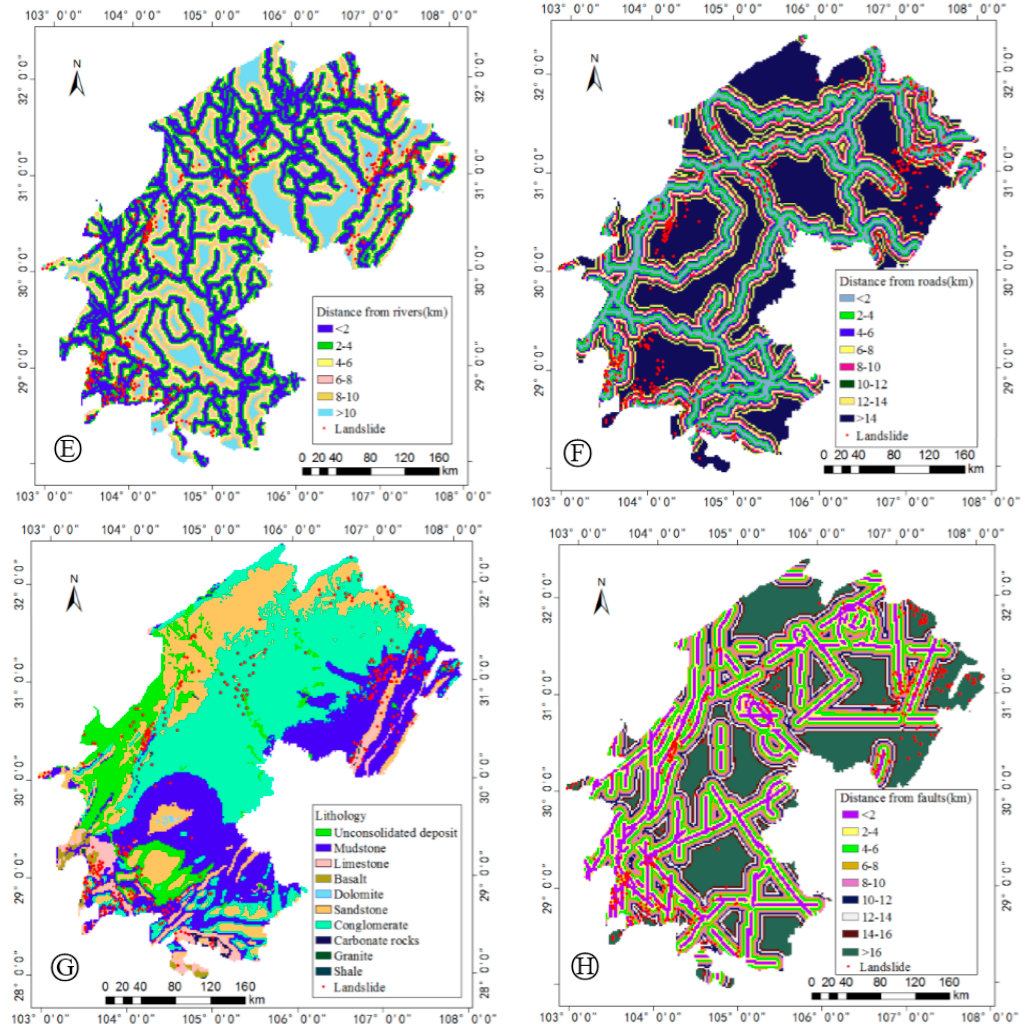
Figure 3. Map of eight landslide predisposing factors. ( A ) Slope; ( B ) altitude; ( C ) relief; ( D ) NDVI; ( E ) rivers; ( F ) roads; ( G ) lithology; ( H ) faults.